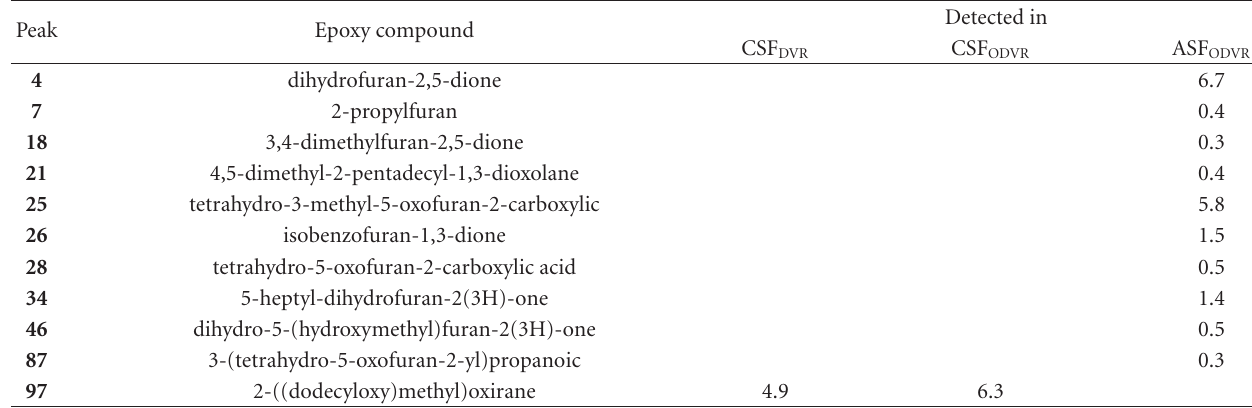
Table 11: ECs detected in the products from CSF DVR , CSF ODVR and ASF ODVR